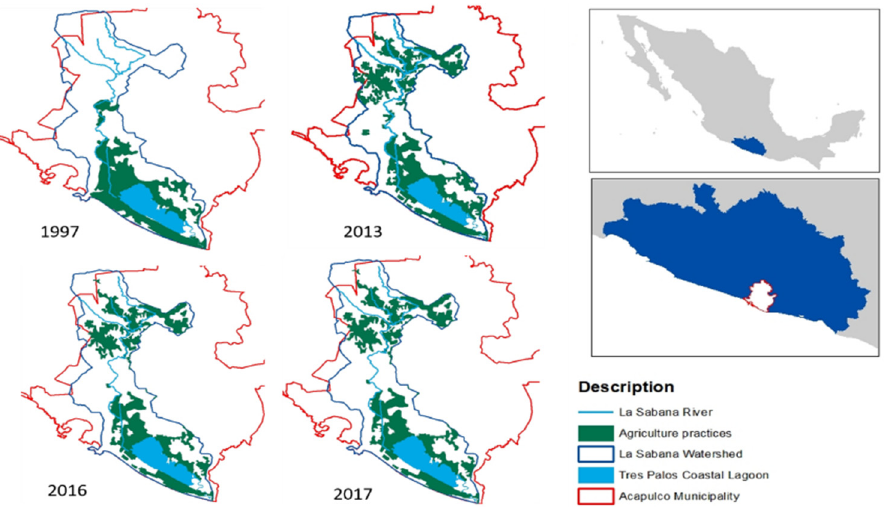
Figure 6. The increase of agricultural practices, from 1997 to 2017, along the river and around the